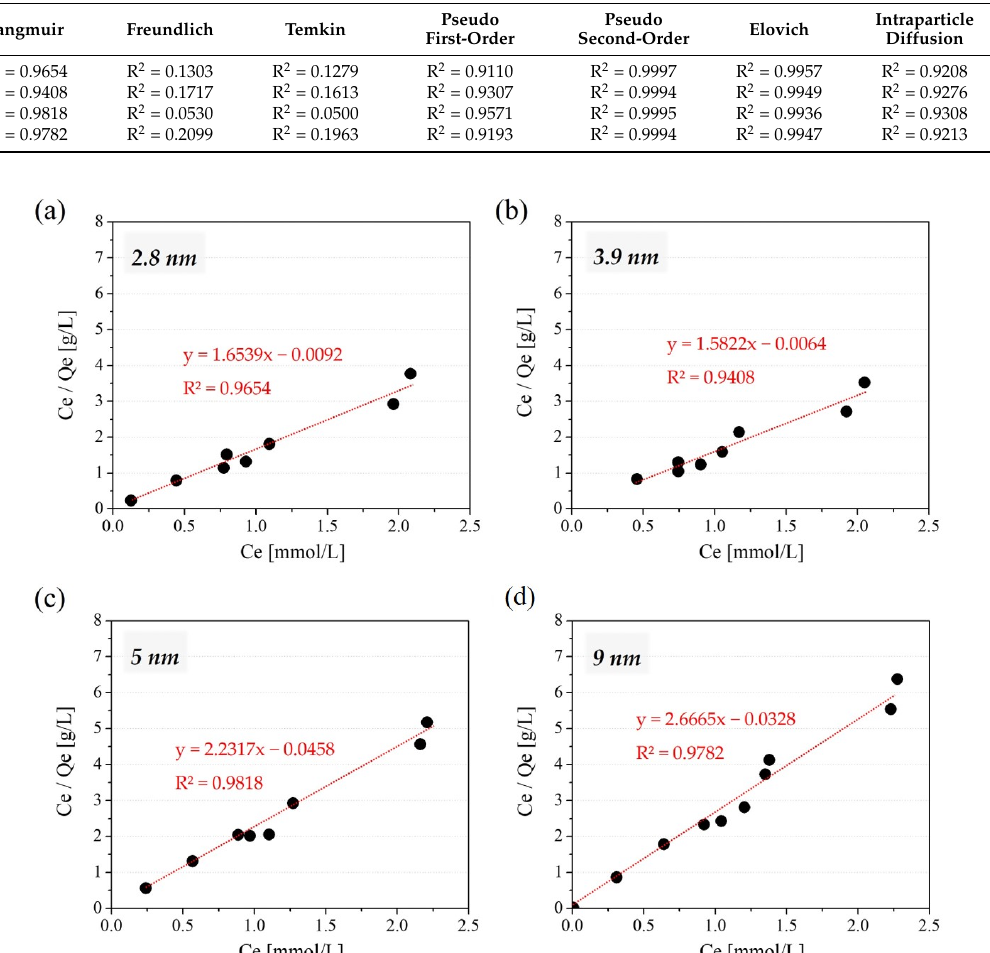
Figure 7. Langmuir plot for Zn adsorption amount on amine-modified MS with the initial MS pore size of 2.8 nm ( a ), 3.9 nm ( b ), 5 nm ( c ), and 9 nm ( d ) in a single-component system ranging from 0.15–2.5 mmol/L of Zn.